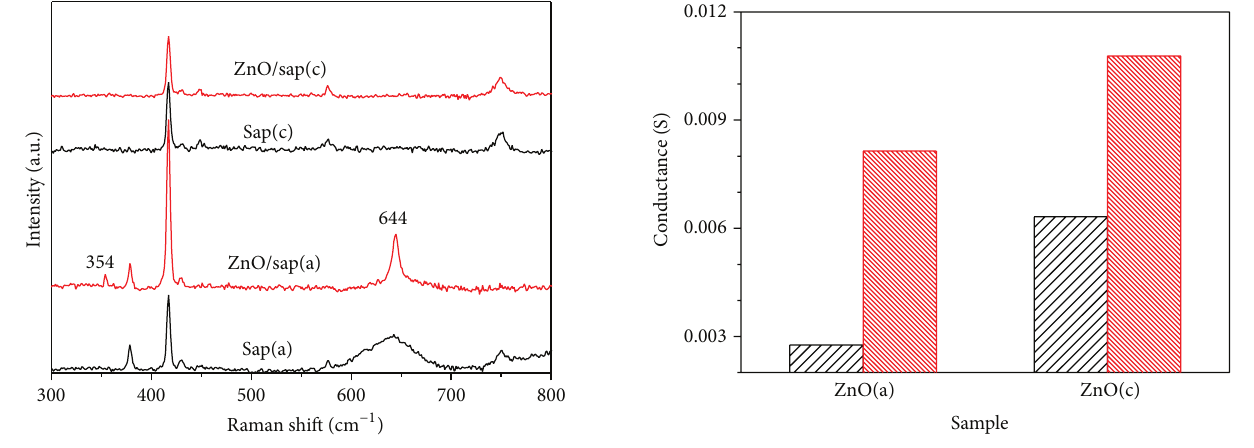
Figure 3: Raman spectra obtained from ZnO thin films grown on a-plane and c-plane sapphire.